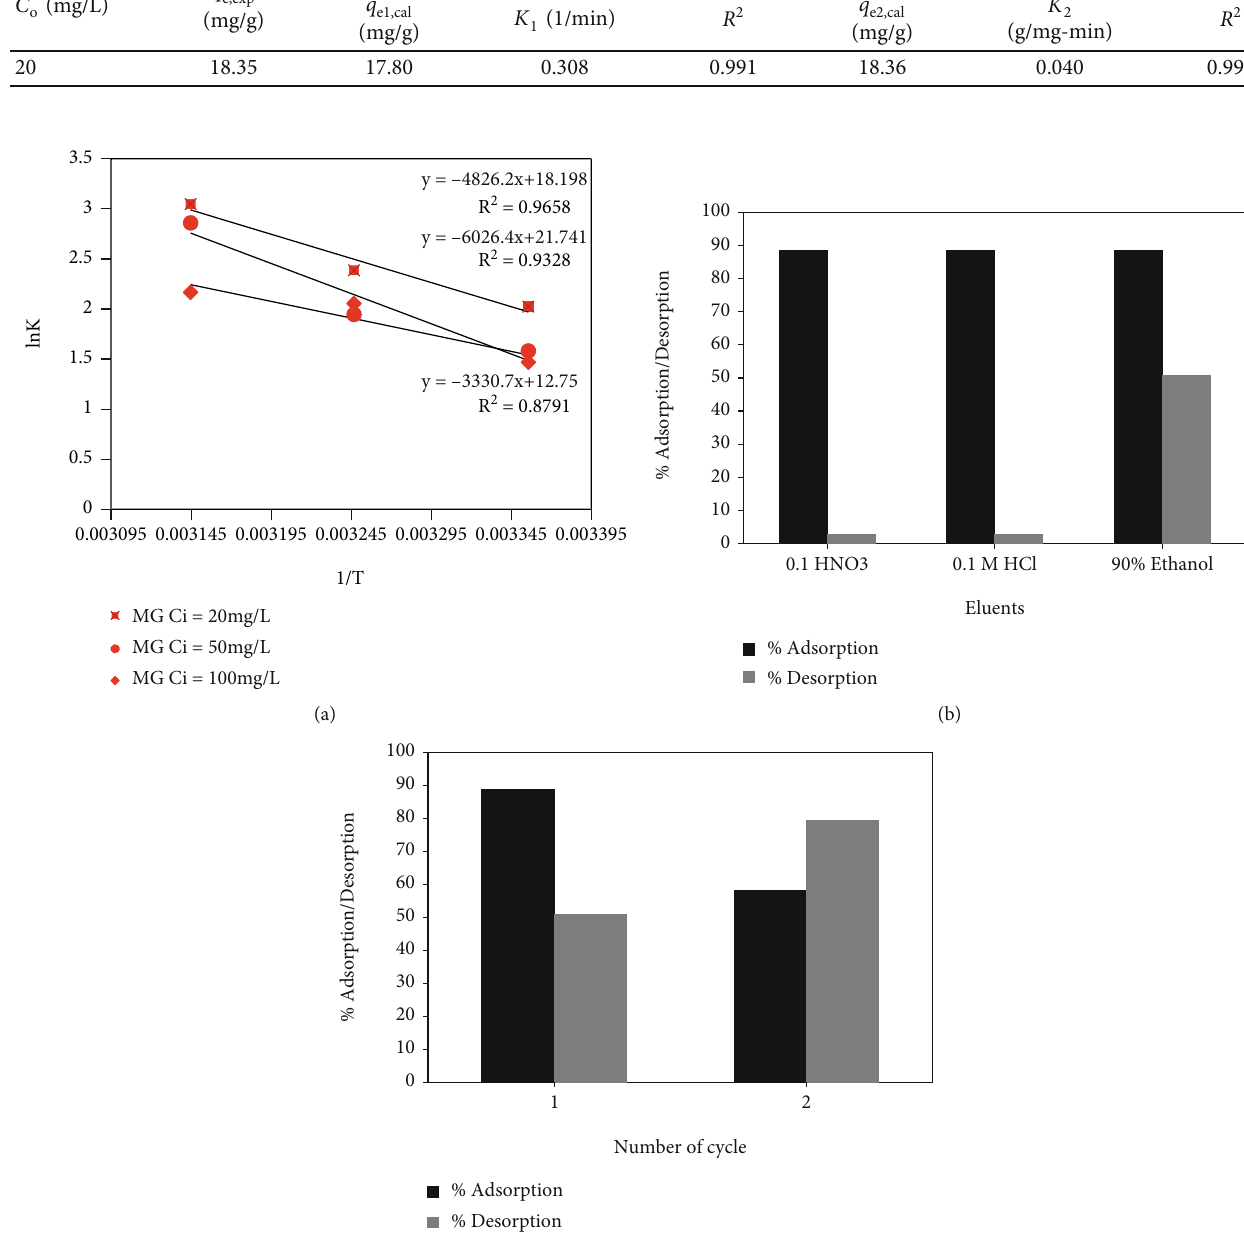
O @AJPAL, and (c) recycling study 3 4